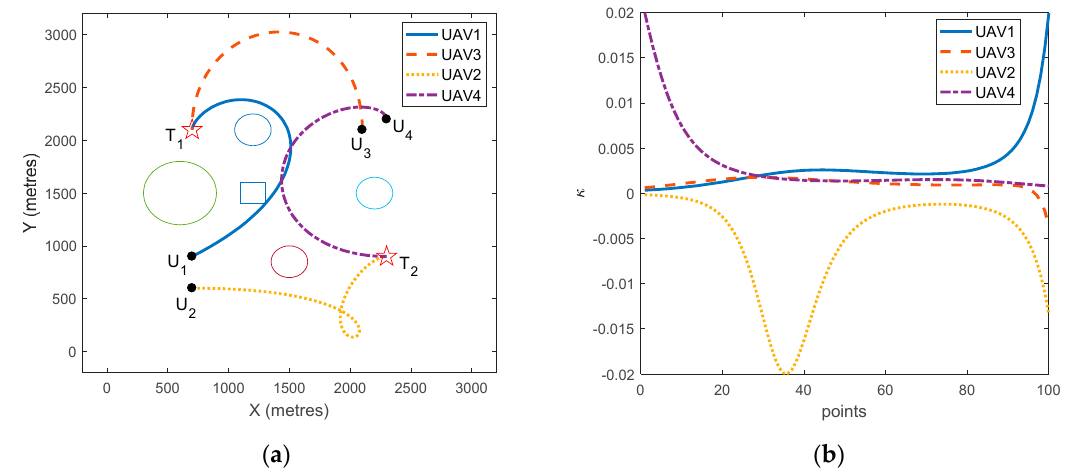
Figure 4. ( a ) Mission planning results (straight line is used in the path estimation process); ( b ) curvature of each UAVs’ path.